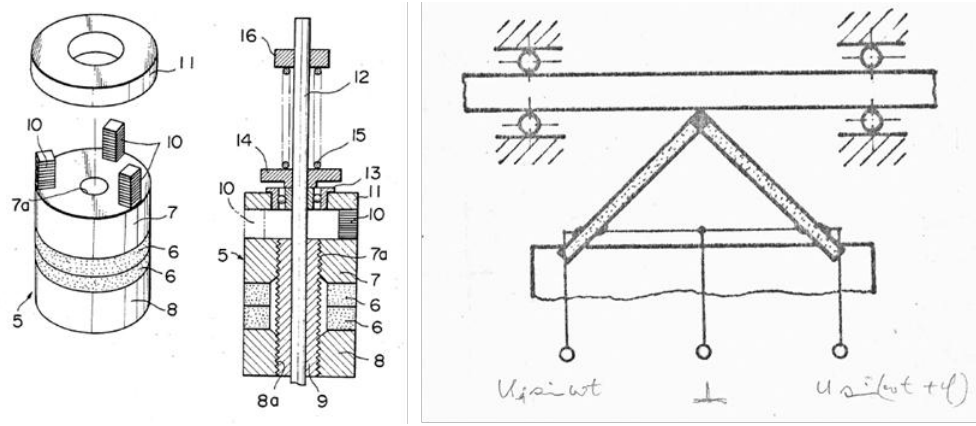
Figure 13. Ultrasonic motors in which multiple piezoelectric elements are used in a stator element. Torsional-Longitudinal ( left ) [40] and Longitudinal-Longitudinal ( right ) [41].